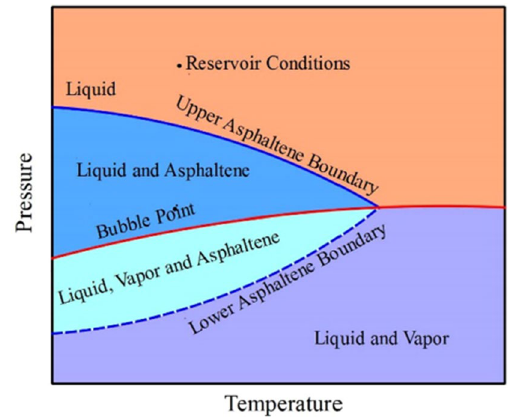
Fig. 13 Asphaltene phase envelope example (Akbarzadeh et al. 2007)